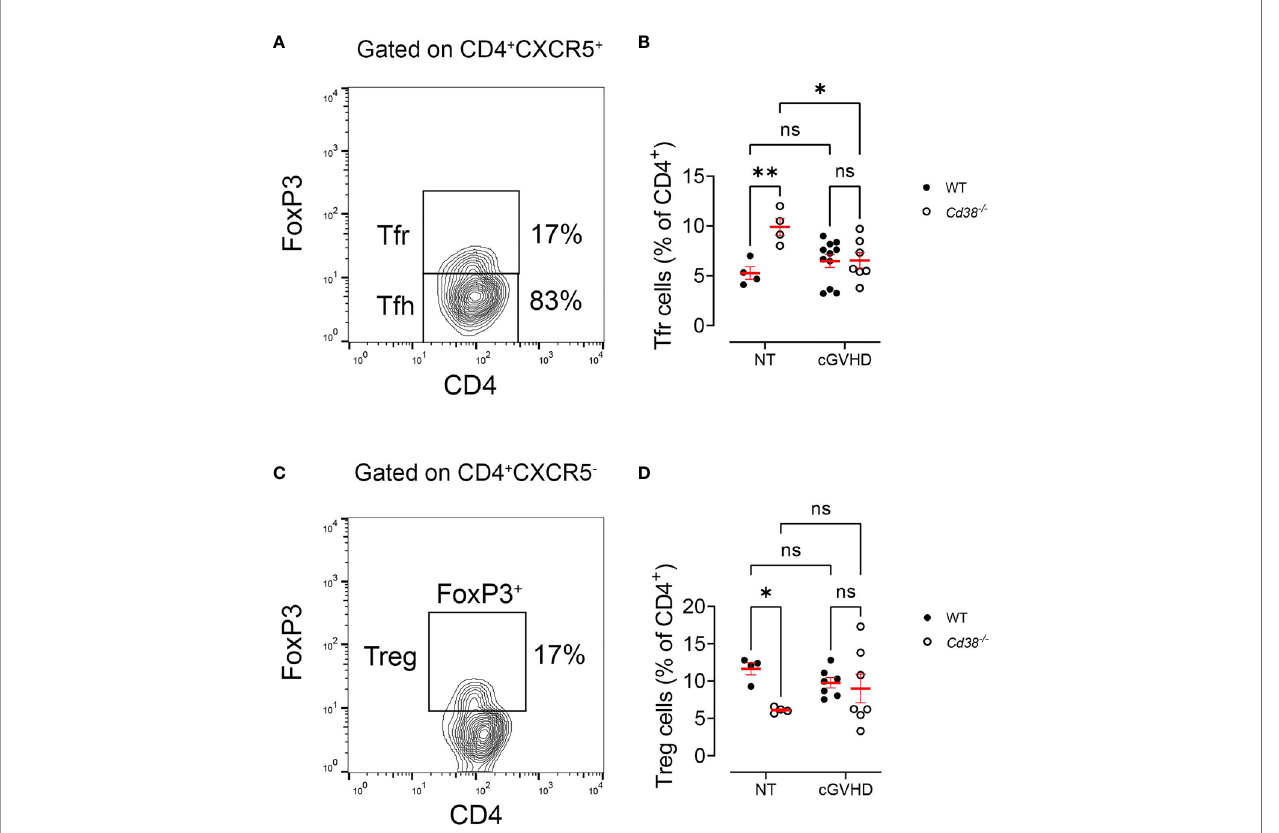
FIGURE 4 | Normal expansion of Tfr cells and Treg cells in Cd38 − / − cGVHD mice. (A, C) Gating strategy used to detect total Tfr cells (independently of PD-1 expression) and Treg cells. (A) Representative fl ow cytometry plot showing FoxP3 + Tfr cells and FoxP3 − Tfh cells on gated CD4 + CXCR5 + T cells. (B) Frequencies of Tfr cells (% of CD4 + ) in non-treated (NT) mice or after 2 weeks of i.p. injection of bm12 cells (cGVHD). (C) Representative fl ow cytometry plot showing FoxP3 + Treg cells on gated CD4 + CXCR5 − T cells. (D) Frequencies of Treg cells (% of CD4 + ) in NT mice or after 2 weeks of i.p. injection of bm12 cells (cGVHD). In panels (B) and (D) WT mice (closed circles) and Cd38 − / − mice (open circles). Horizontal bars represent mean values and vertical bars ± SEM. The P -values are for two-way ANOVA test for multiple comparisons (Fisher ’ s LSD test). ns, not signi fi cant ( P > 0.05), * P < 0.05, ** P <